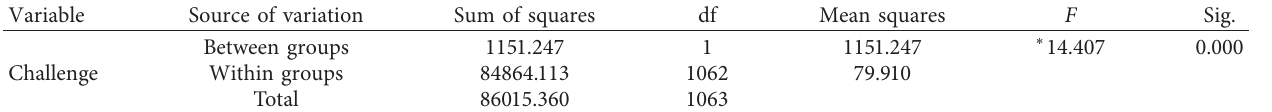
Table 7: Summary of ANOVA for issues related to challenges of cooperative learning by